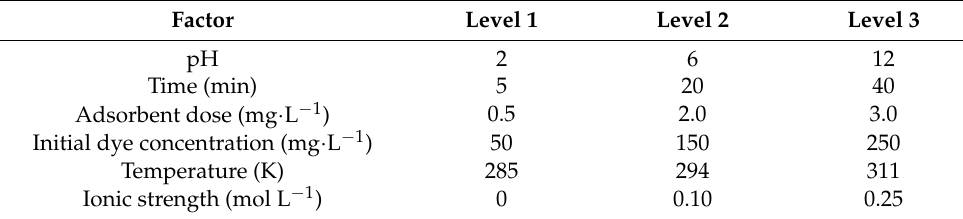
Table 1. Controllable factors and their levels.